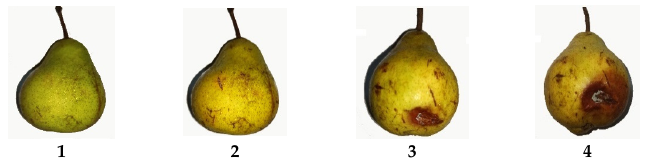
Figure 12. Empirical damage scale used for scale of the pear, where 1 = no damage (0% damage), 2 = mild damage (10–15% damage), 3 = moderate damage (25–50% damage), and 4 = severe damage (>50%